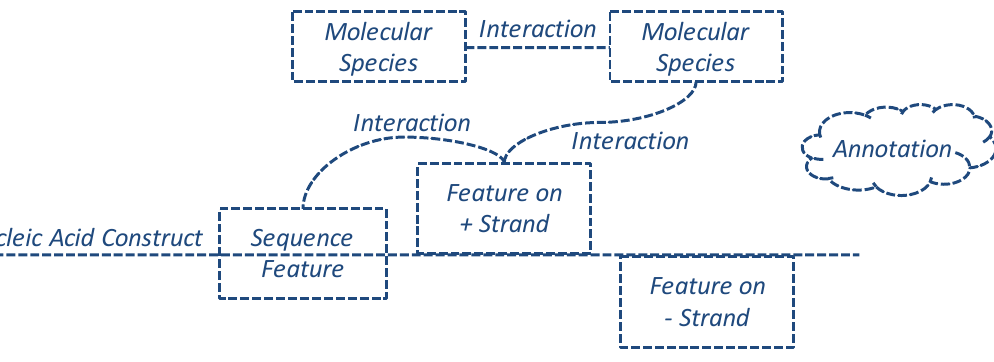
Figure 4: Generic syntax of SBOL Visual 3: a diagram for a nucleic acid construct is based around a backbone line, its structure specified by the sequence of attached sequence feature glyphs. Strand can optionally be indicated by placing a glyph above or below the backbone. Other molecular species are indicated by glyphs not in contact with any backbone. Interactions are directed edges connecting sequence feature or molecular species glyphs. Any of these objects may